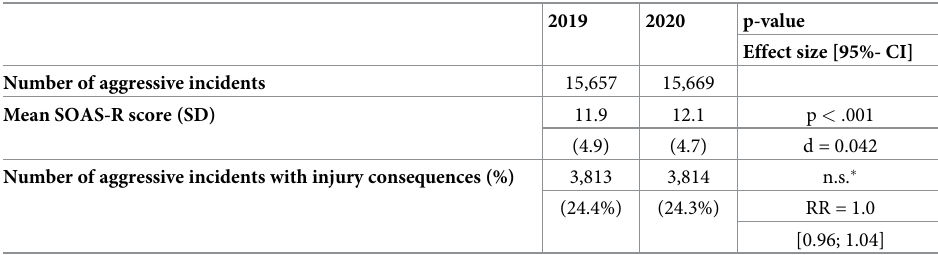
Table 5. Number of aggressive incidents in 2020 compared to